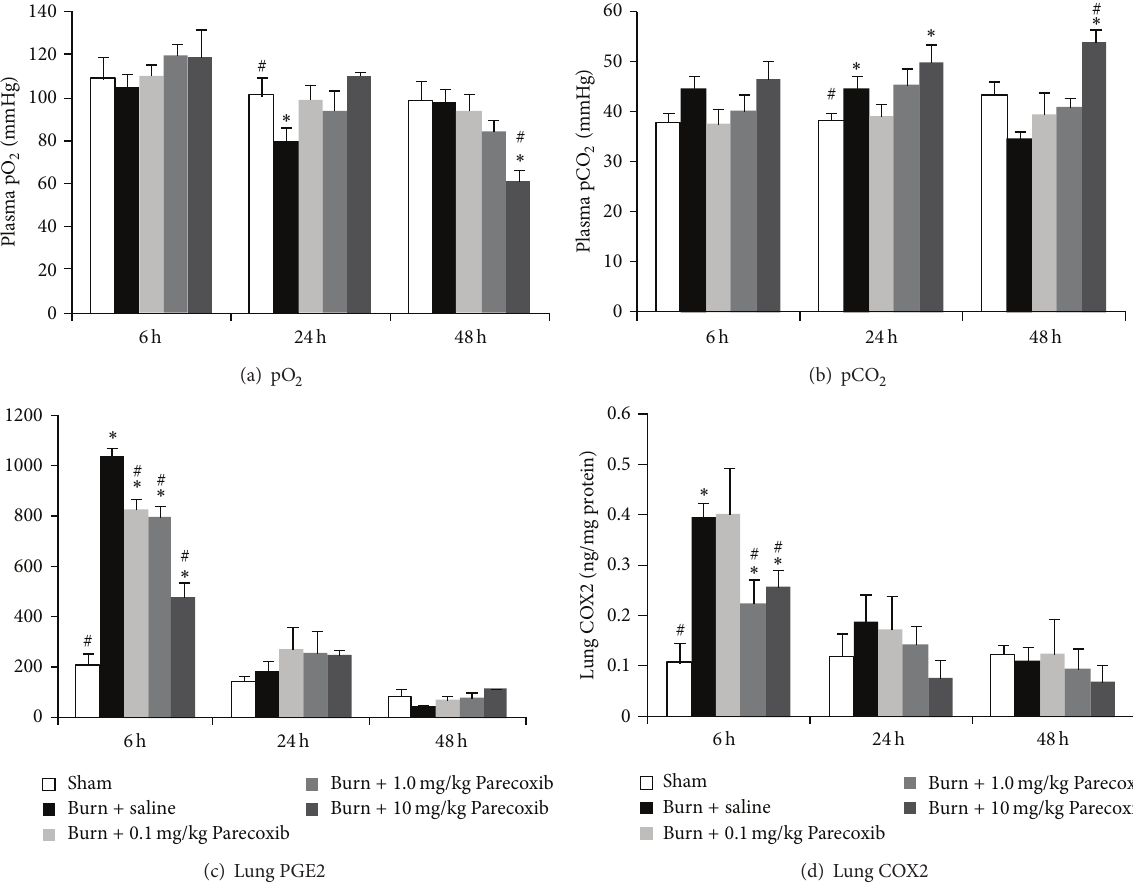
Figure 2: Changes in arterial blood gases and metabolic parameters over 48 h after burn injury. (a) pCO 2 ; (b) pCO 2 ; (c) lung PGE2; and (d) lung COX2. ∗ Significantly different from Sham group. # Significantly different from burn + saline group ( 𝑃 < 0.05 , one-way ANOVA, Bonferroni post-hoc